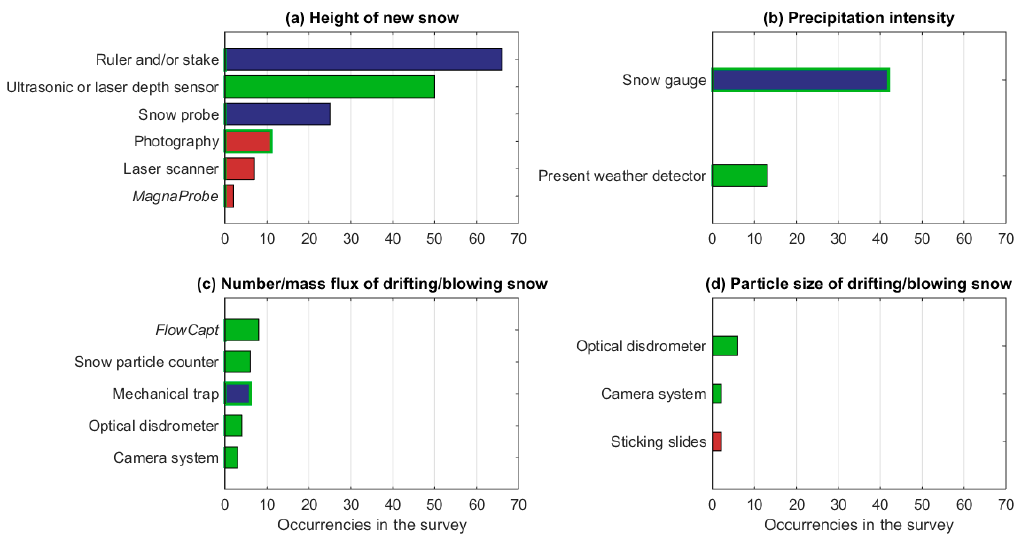
Figure 12. Occurrences of the applied instruments to measure the precipitating and suspended snow properties, such as the height of new snow ( a ), precipitation intensity ( b ), number/mass flux of drifting/blowing snow ( c ), and particle size of drifting/blowing snow ( d ). Different colors denote manual instrument without electronics (blue), manual instrument with electronics (red), manual instrument without electronic or fully automatic depending on the version of the instrument (blue with green contour), manual instrument with electronic or fully automatic depending on the version of the instrument (red with green contour), and fully automatic instrument (green).